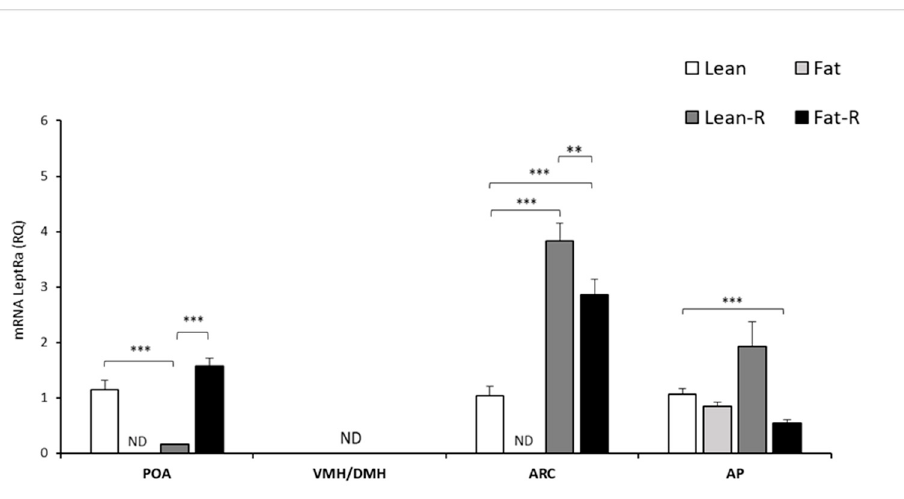
Figure 4. Leptin receptor isoform a mRNA expression. The mean mRNA expression (±SEM) of the short form of the leptin receptor ( LRa ) in the ovine preoptic area (POA), ventro ‐ and dorsomedial nuclei (VMH/DMH), arcuate nucleus (ARC) and anterior pituitary gland (AP). The expression of LRa mRNA is reported in arbitrary units (RQ) relative to cyclophilin mRNA expression and expressed relative to the calibrator sample. Differences relative to the control or between the other groups are indicated with ** p < 0,01; *** p < 0.001.